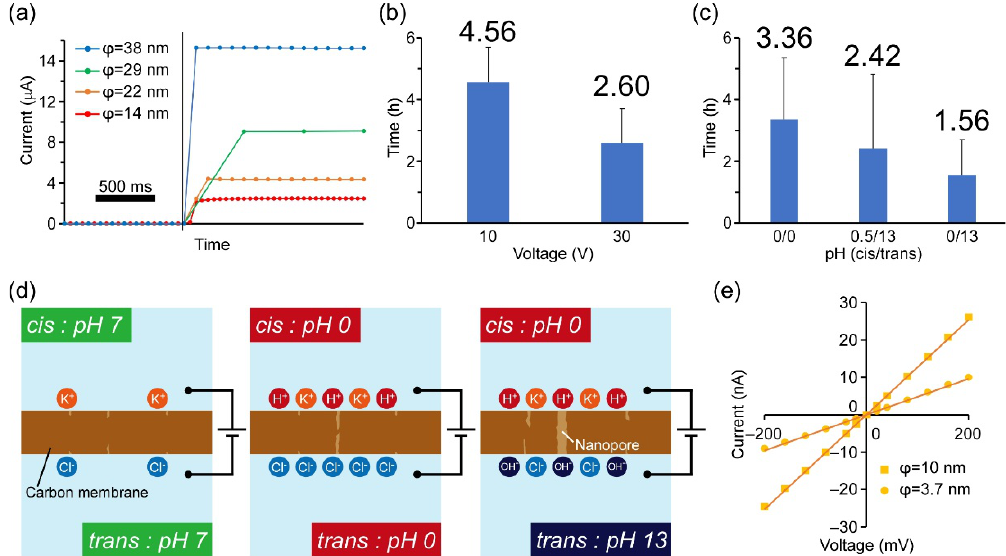
Figure 3. Nanopore fabrication using method 2 (DB + carbon membrane). ( a ) Current and time traces of the DB experiments with several different nanopore formations estimated from the ion currents. ( b ) The time of nanopore formation by applying different voltages (pH 0.5/0.5.) ( c ) The time of nanopore formation depending on the pH gradations; ( cis / trans ) means (positive/negative) application of voltages. ( d ) Schematic diagrams of the proposed mechanism for the break down by pH gradation. ( e ) I-V curves of the nanopores fabricated by the DB method for different pore sizes.